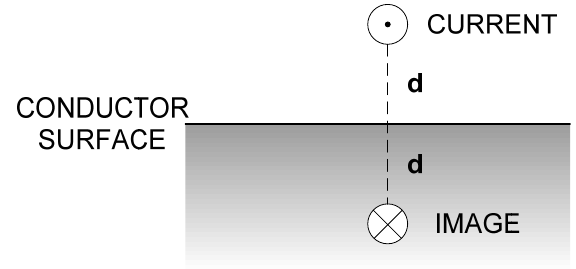
Figure 4. Method of images for eddy currents